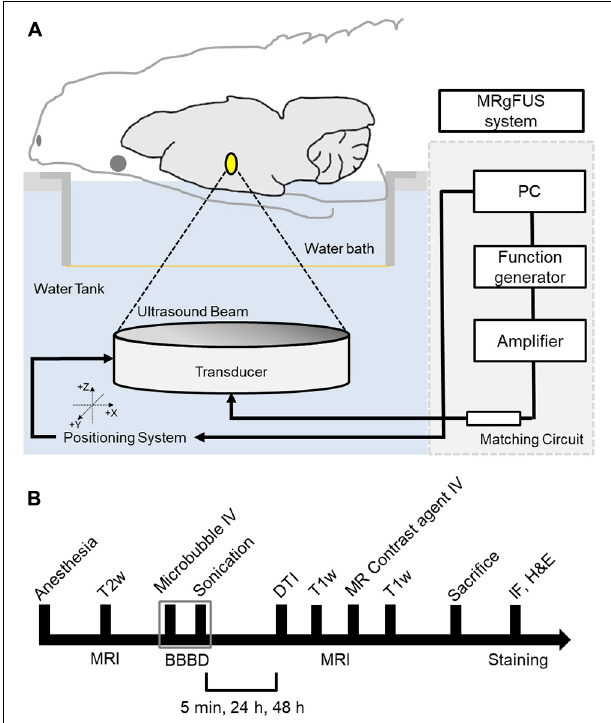
FIGURE 1 | Schematic of the MRI-guided FUS system and experimental design. (A) The animal is in supine position with its head submerged in water tank. The focal area is targeted with MR image guidance and PC-controlled positioning system. (B) Experimental design for investigating the effects of FUS–BBBD on water transport. T2-weighted MR images were obtained to locate the focal region before the sonication, and T1-weighted images and diffusion tensor images were acquired for each time slot (5 min, 24 and 48 h) after the FUS–BBBD. Sprague–Dawley rats were sacrificed and perfused for staining after 48 h after the